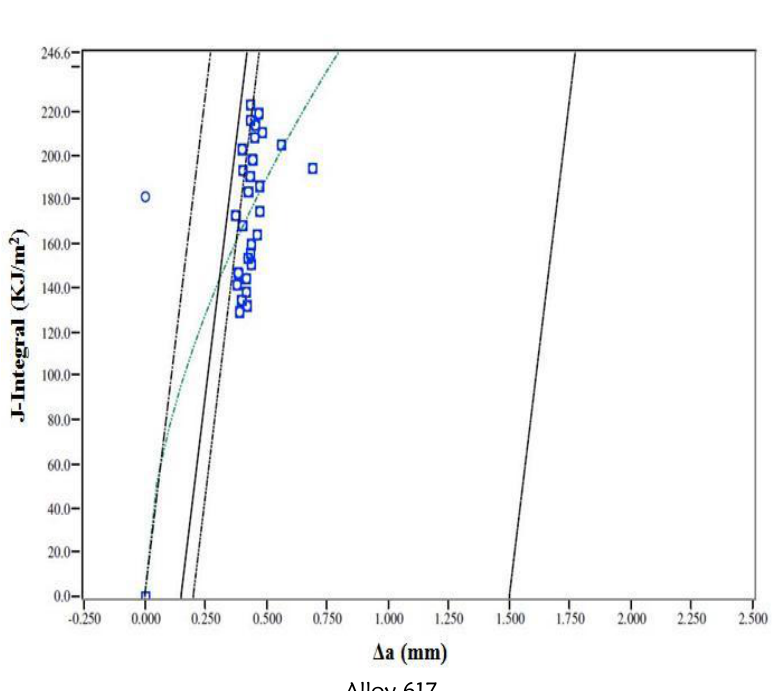
Figure 8: J-Integral vs. Δ a at Ambient Temperature